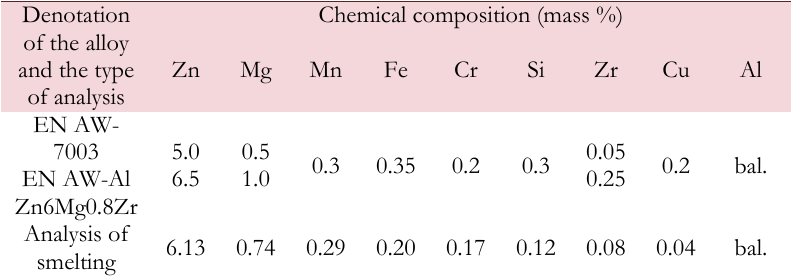
Table 1: Chemical composition of investigated alloy.